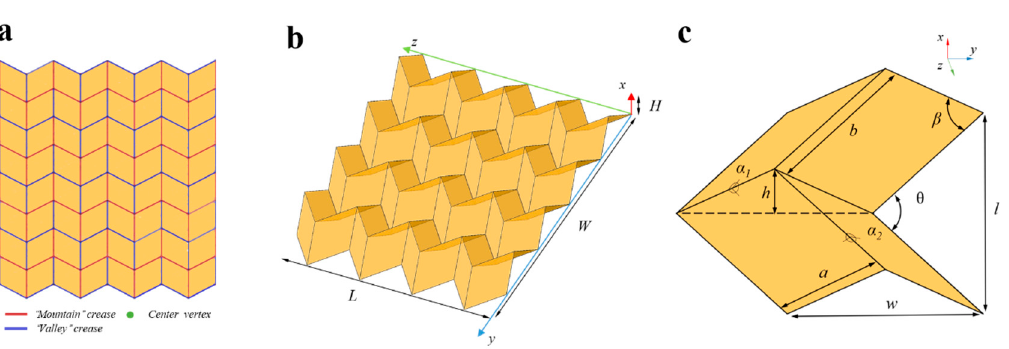
Figure 1. Illustration of Miura-ori. ( a ) A Miura-ori in its planner state; red lines represent ‘‘mountain’’ creases, the blue lines represent ‘‘valley’’ creases. ( b ) Miura-ori in its folded state; the red lines are on the top, and the blue lines are on the bottom, four vertices in the z direction, four vertices in the y direction. ( c ) A unit cell of Miura-ori; α 1 and α 2 are two dihedral angles. In each parallelogram, the length of the short side is a and that of the long side is b, with an acute angle of β . The projected angle between the two ridges is θ . The size of the unit cell is H, W, and L in the x , y , and z directions.